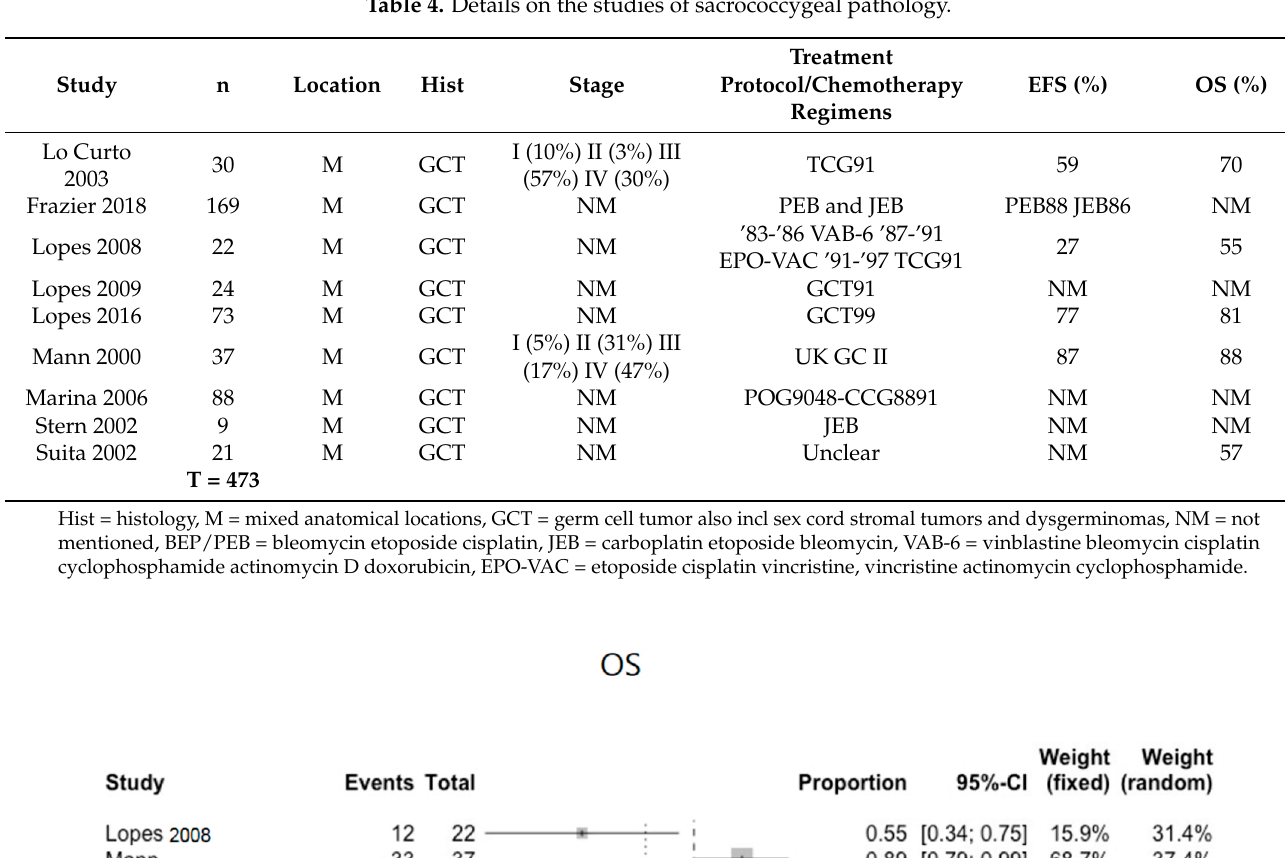
Table 4. Details on the studies of sacrococcygeal pathology.